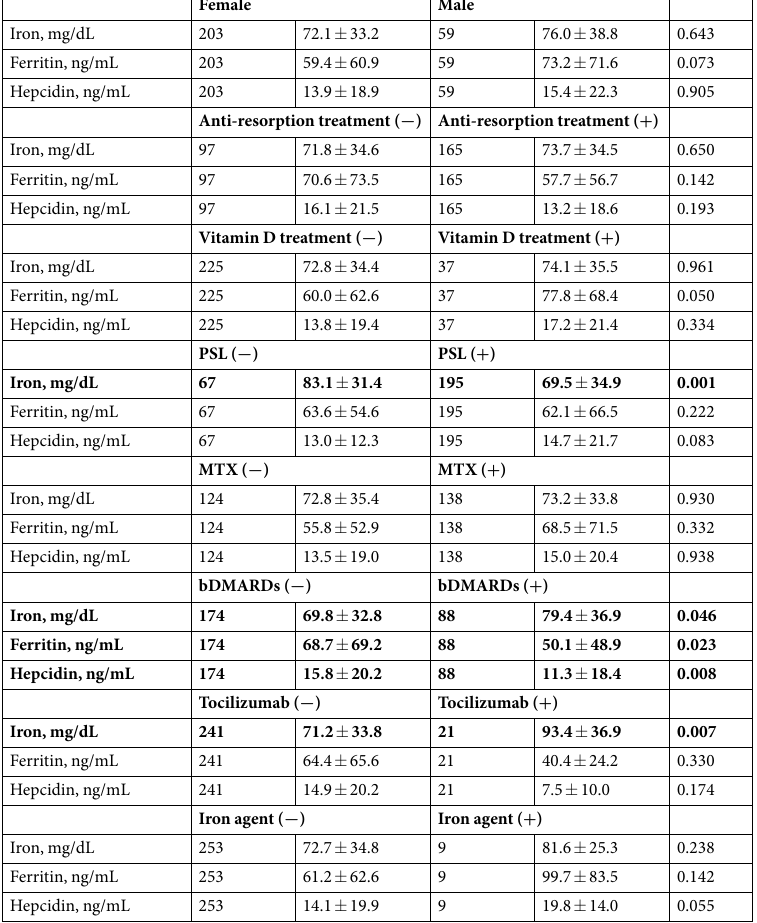
Table 3. Relationships between serum iron, ferritin, and hepcidin and categorical variables. Data are numbers of patients, mean ± S.D. Anti-resorption treatment included bisphosphonate and denosumab use. bDMARDs included anti-TNF and tocilizumab treatment. Vitamin D treatment was the use of active form of vitamin D preparation. PSL, prednisolone; MTX, methotrexate; DMARDs, disease-modifying antirheumatic